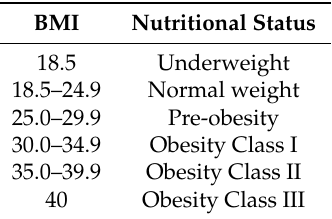
Table 1. Nutritional